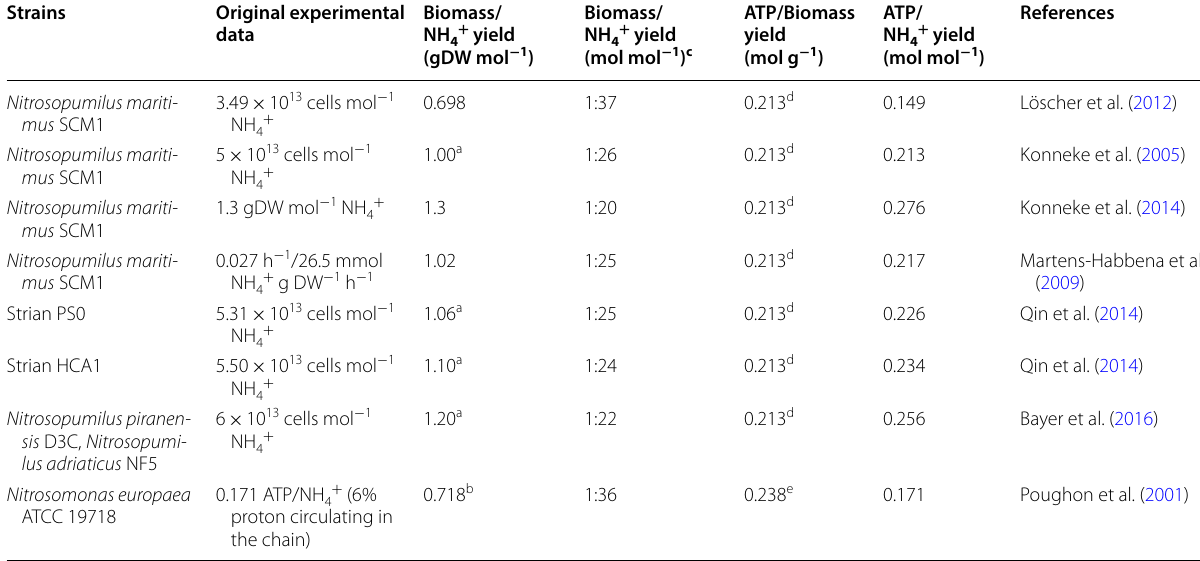
Table 4 Experimentally measured and computationally calculated yield values for strain SCM1 and other ammonia- oxidizing organisms